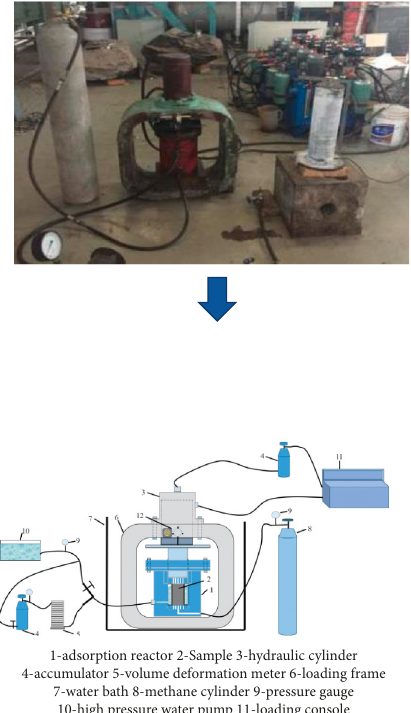
Figure 2: Coal adsorption deformation experimental system.